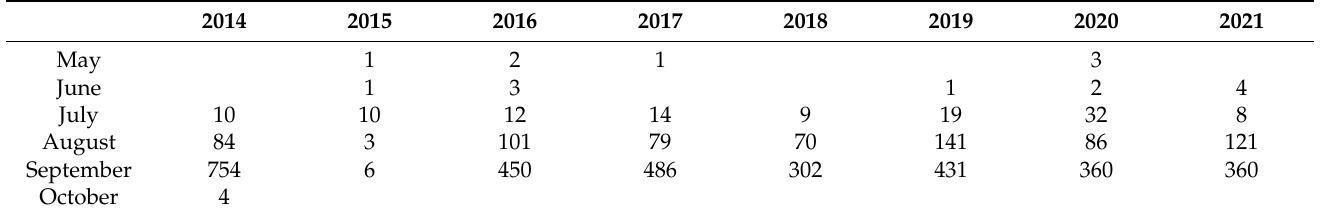
Table 1. Total monthly concentration of Ambrosia pollen between 2014–2021 (pollen grains/mm 3 air).